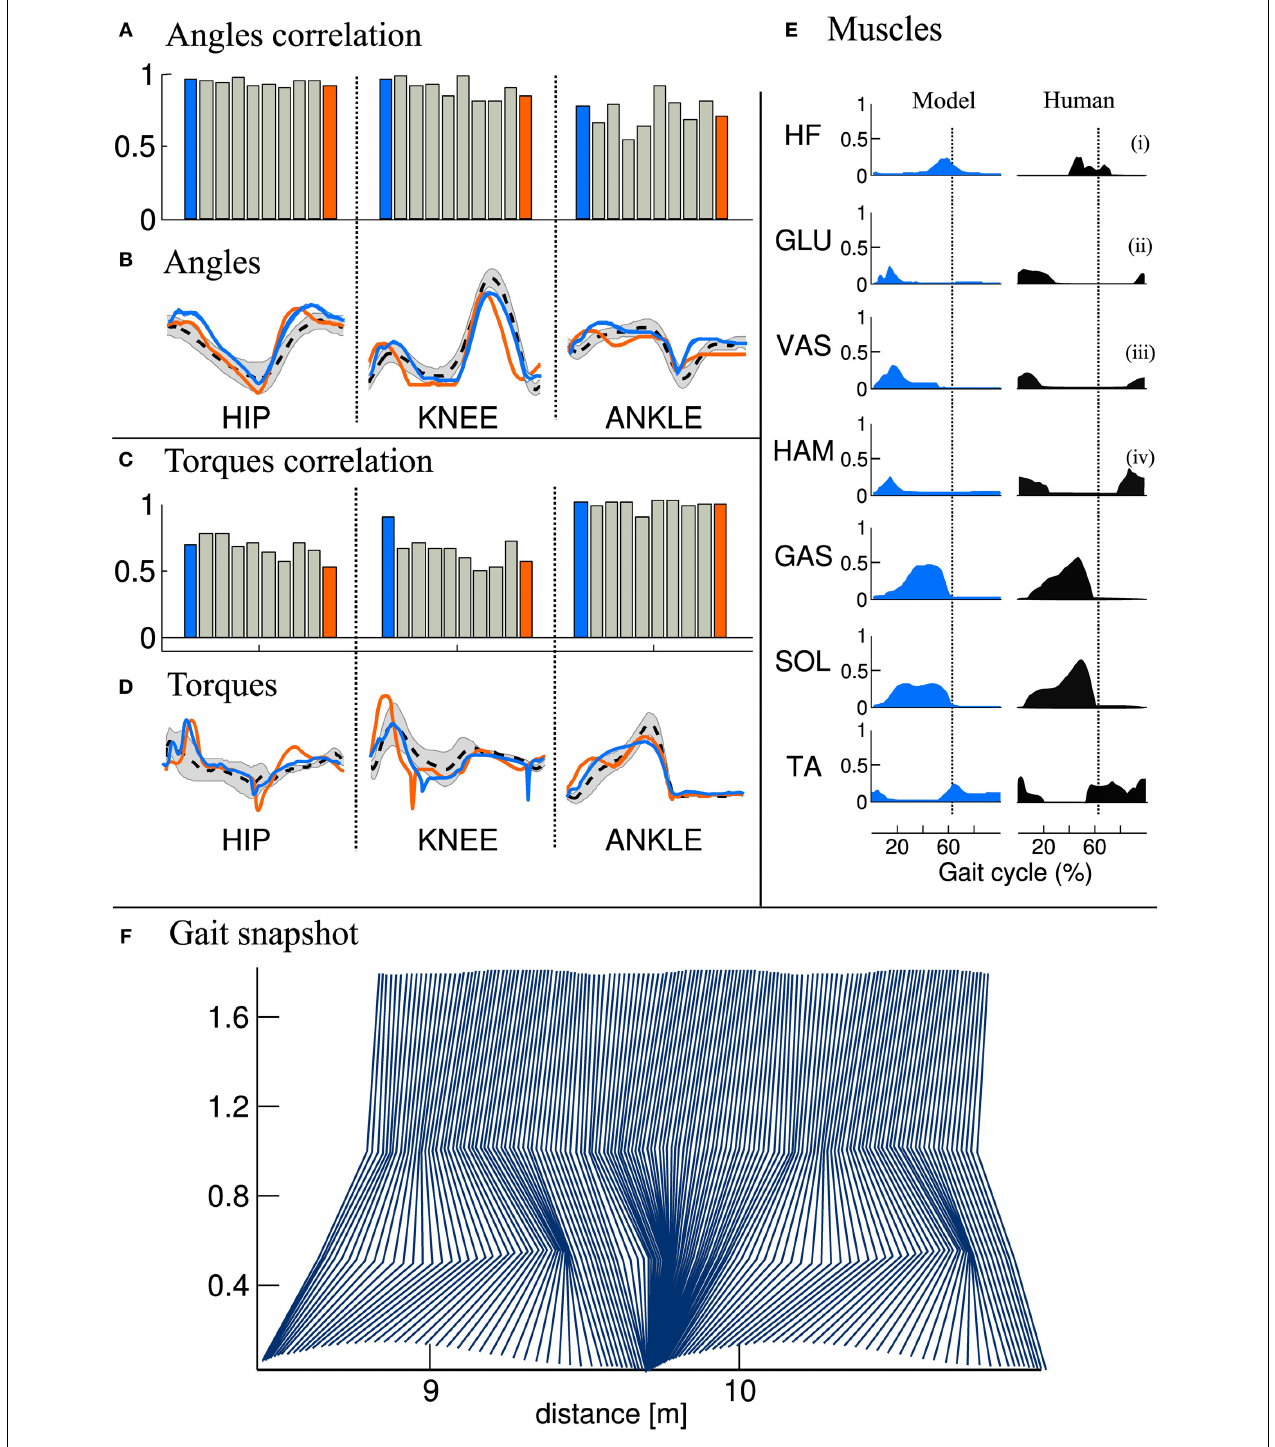
FIGURE 5 | Comparison of joints angle, joints torque and muscles activity extracted from the FBL models (10 optimization runs), with human data. Human joints angle and torque are taken from Winter (2009), muscles activities are adapted from Perry et al. (1992), as presented in Geyer and Herr (2010). (A) Joint angle correlation with human, (B) Average joint angle compared to human, (C) Joint torque correlation with human, (D)